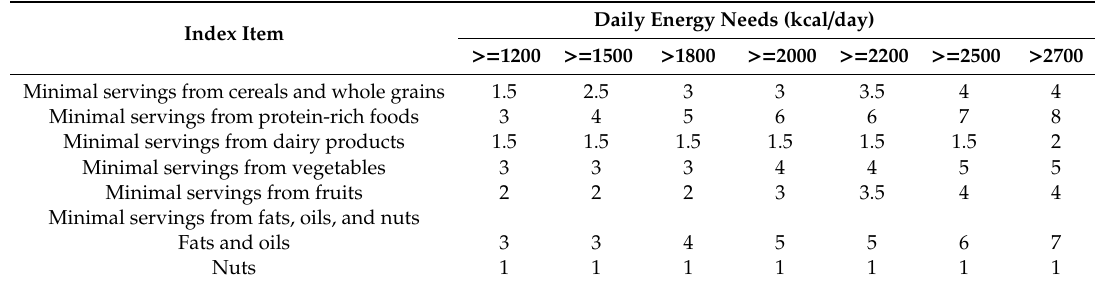
Table 1. Daily Food Guide for adults in